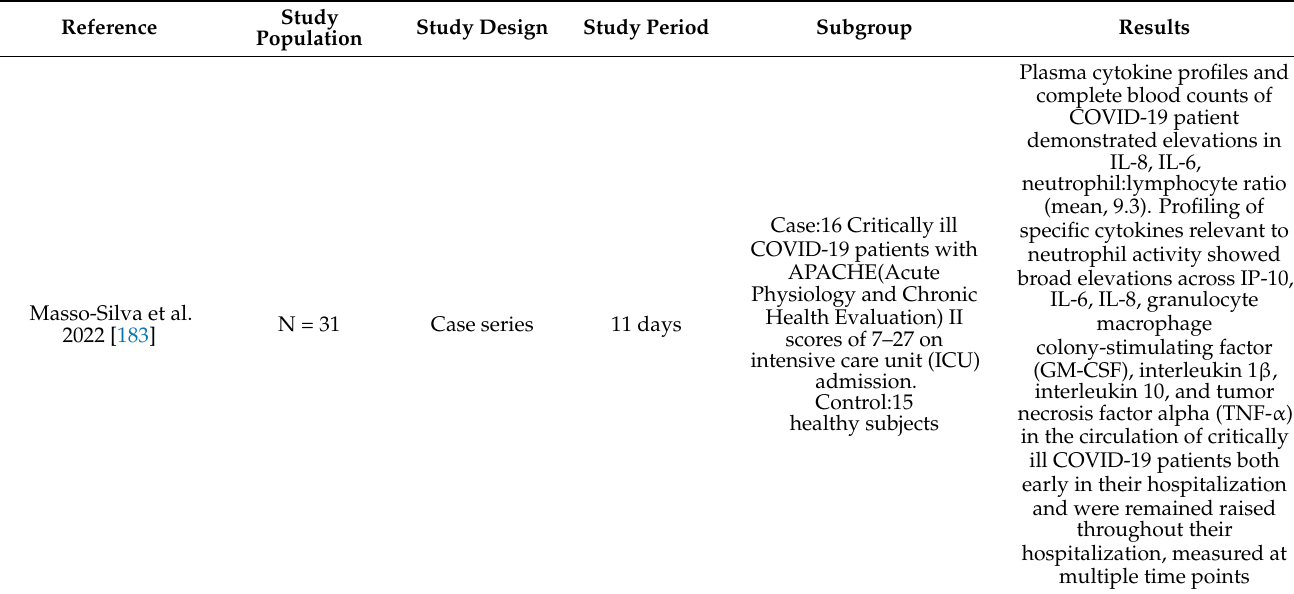
Table 1. Illustrating the studies showing immune response of human body to SARS-CoV-2 infection